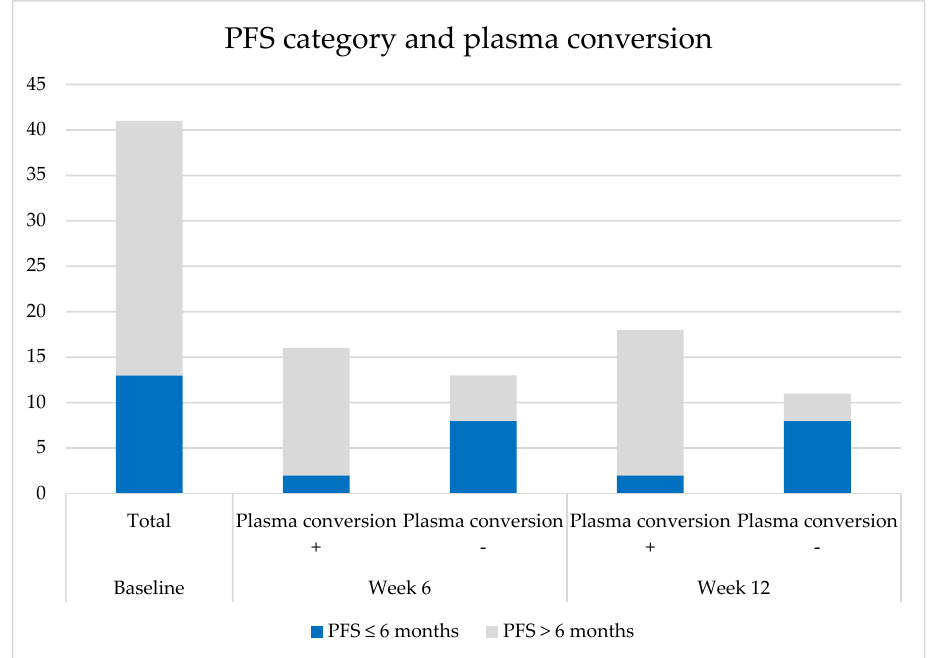
Figure 2. PFS category distribution and plasma conversion in time.